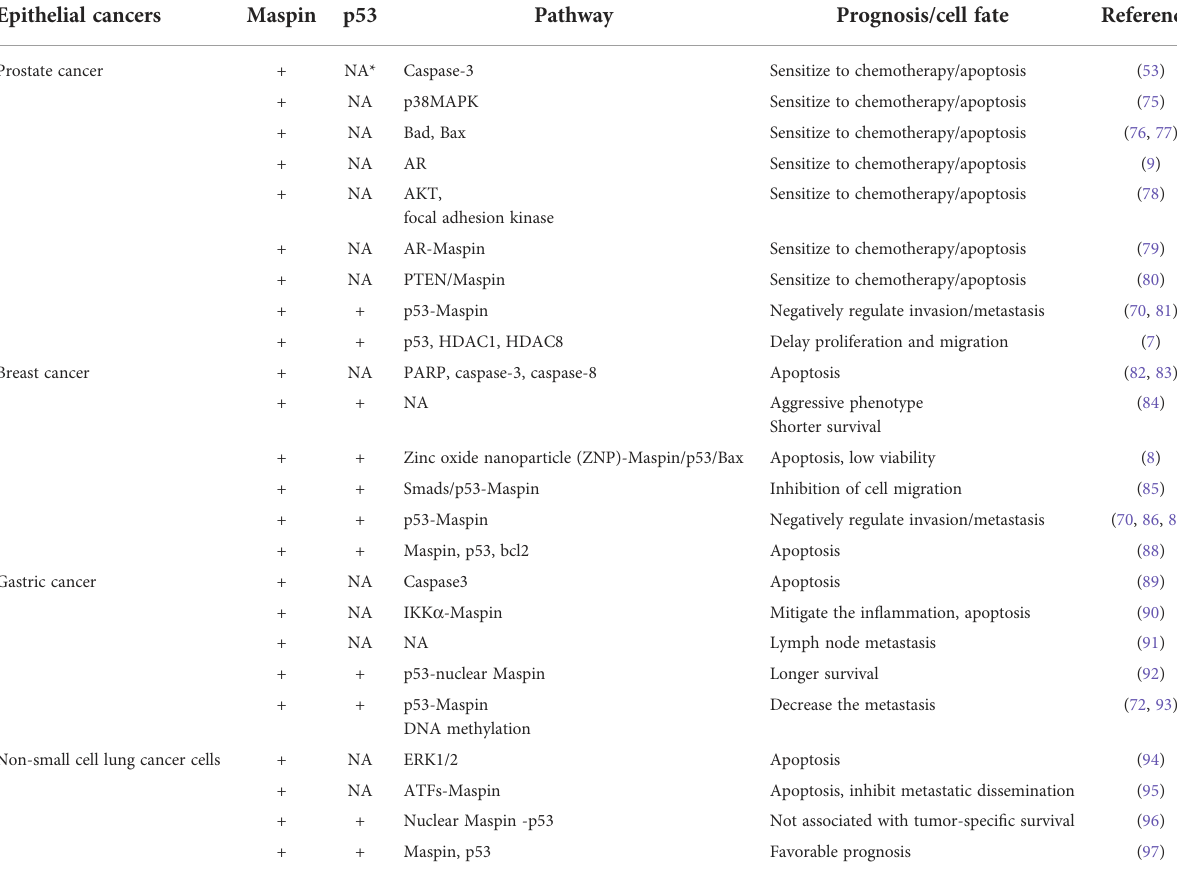
TABLE 1 The antitumor activity of Maspin-associated molecules/pathways in common human cancers. Epithelial